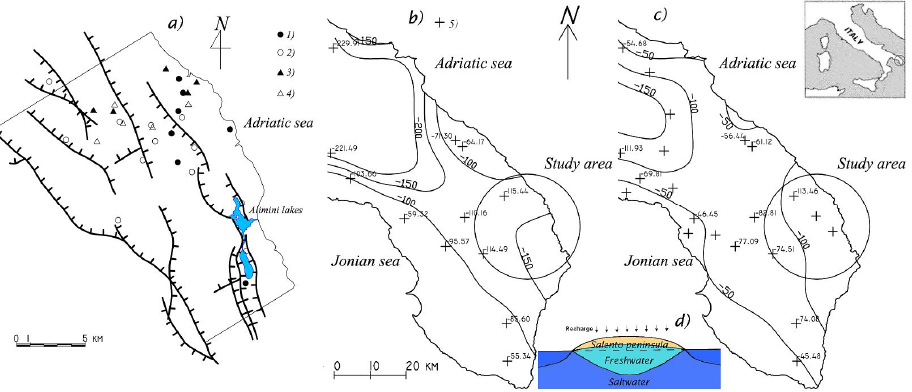
Fig. 10. (a) surveys concerning the shallow aquifer: (1) Surveys carried out in 2007 with TDS > 450mgl − 1 ; (2) Surveys carried out in 2007 with TDS < 450mgl − 1 ; (3) Surveys carried out in 2006 with TDS > 450mgl − 1 ; (4) Surveys carried out in 2006 with TDS < 450mgl − 1 . (b) (5) Surveys concerning the deep aquifer. Interpolated depths of (b) seawater (35gl − 1 ) and (c) interface (5gl − 1 ). (d) conceptual model Figure 10: a) surveys concerning the shallow aquifer:  1) Surveys carried out in 2007 with TDS > 450 mg/l;